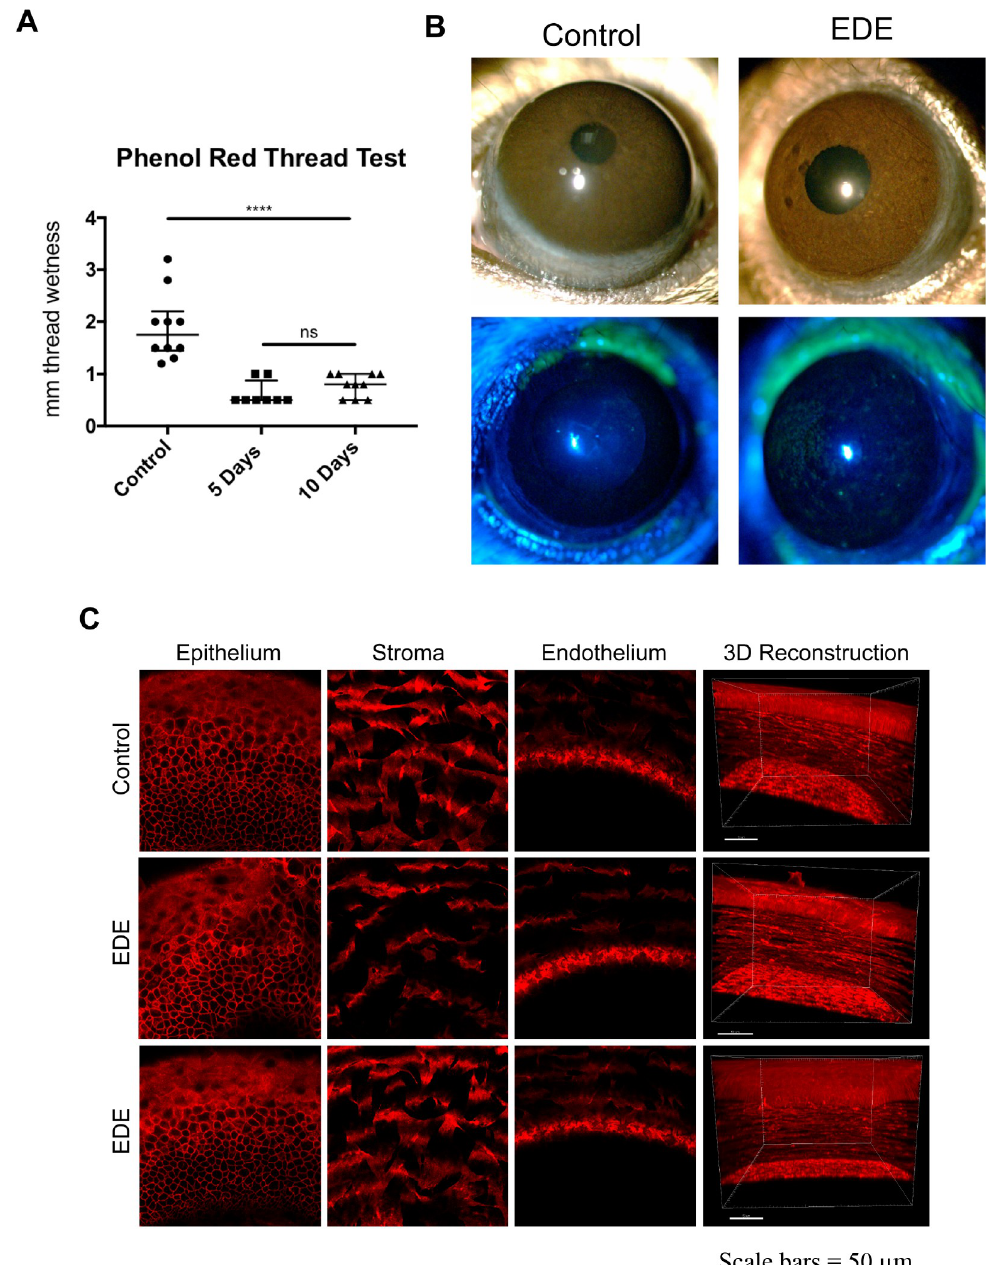
Fig 1. Induction of experimental dry eye. A) Tear volumes in the eyes of C57BL/6J mice under dry eye (EDE) conditions versus normal controls were measured using the phenol red thread tear test. EDE resulted in a significant decrease in tear volume after 5 and 10 days of treatment versus 10 day controls. Tears were collected from the lateral canthus using a cotton thread and reported as millimeters of wetted thread. Data are expressed as the median with lower and upper quartiles. ���� = P < 0.0001, Mann-Whitney U test, ns = not significant (5 mice per group). B) After induction of dry eye for 10 days, representative photographs taken under the dissecting microscope demonstrate no overt changes to the ocular surface with EDE (upper panels). However, increased fluorescein staining in the EDE mice (lower panels) indicate reduced epithelial integrity. C) Transgenic C57BL/6J mice with red fluorescent cell membranes were sacrificed, then eyes enucleated and glued onto a glass cover slip and covered in DMEM to retain viability. Eyes were imaged at 0.5 μ m intervals through the entire cornea. No differences in corneal morphology were detected between EDE and controls. Representative examples of the epithelium, stroma, endothelium, and a 3D reconstruction are shown. All images were taken at 10 days.